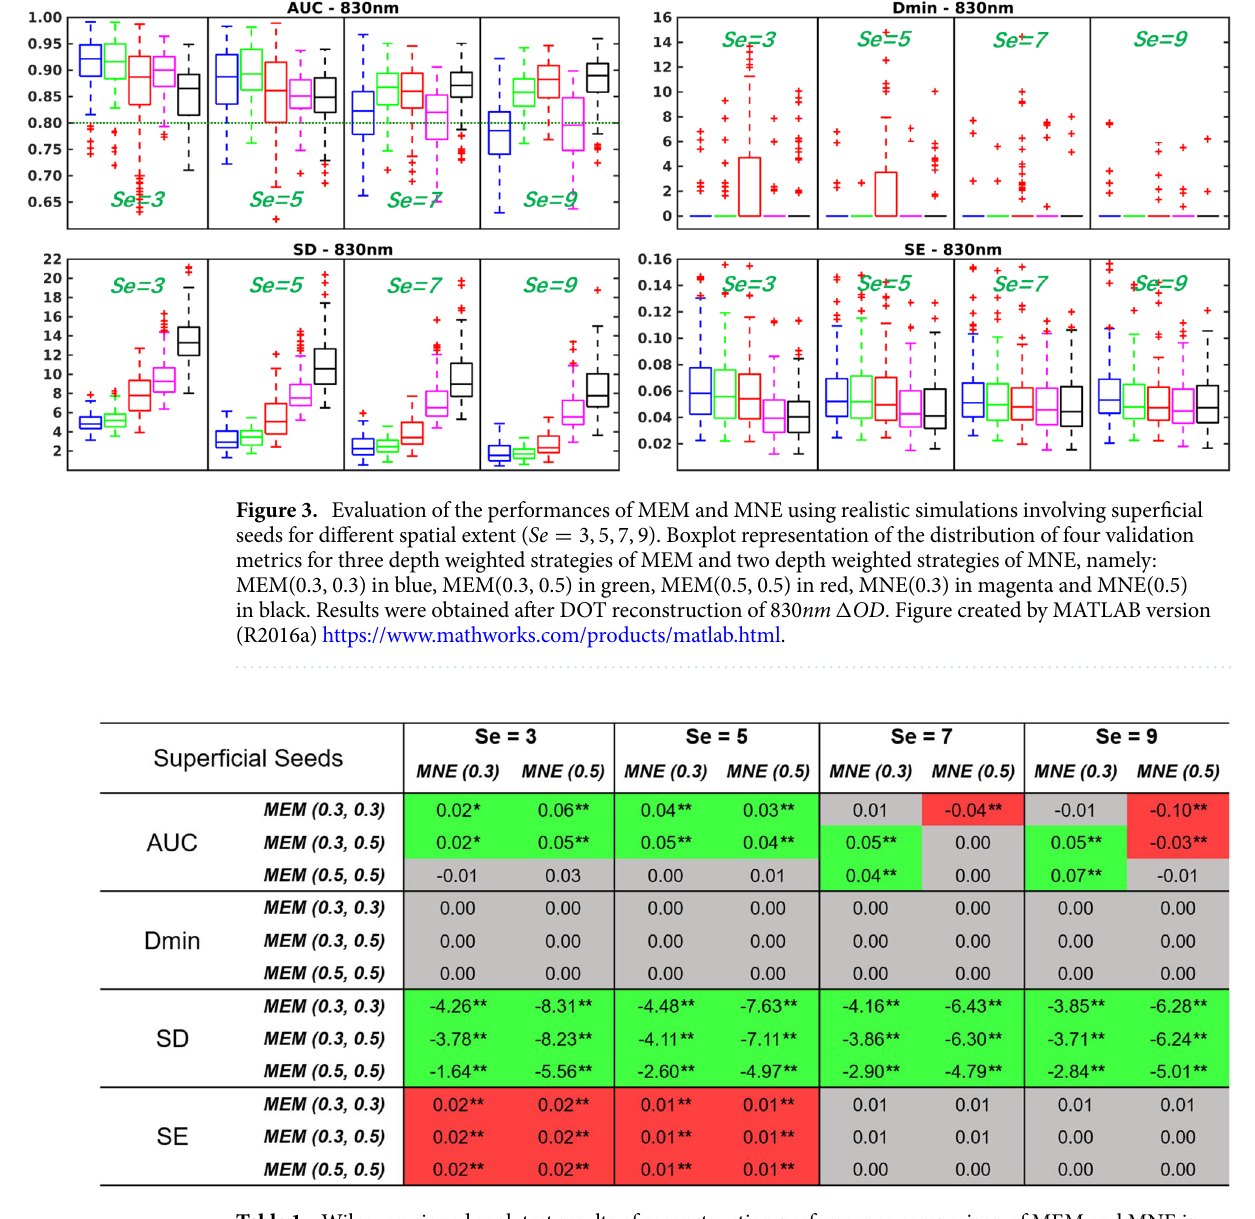
Table 1. Wilcoxon signed rank test results of reconstruction performance comparison of MEM and MNE in superficial seeds case. Median values of paired difference are presented in the table. p values were corrected for the paired difference of each validation metrics is color coded as follows: green: MEM is significantly better than MNE, red: MNE is significantly better than MEM and gray: